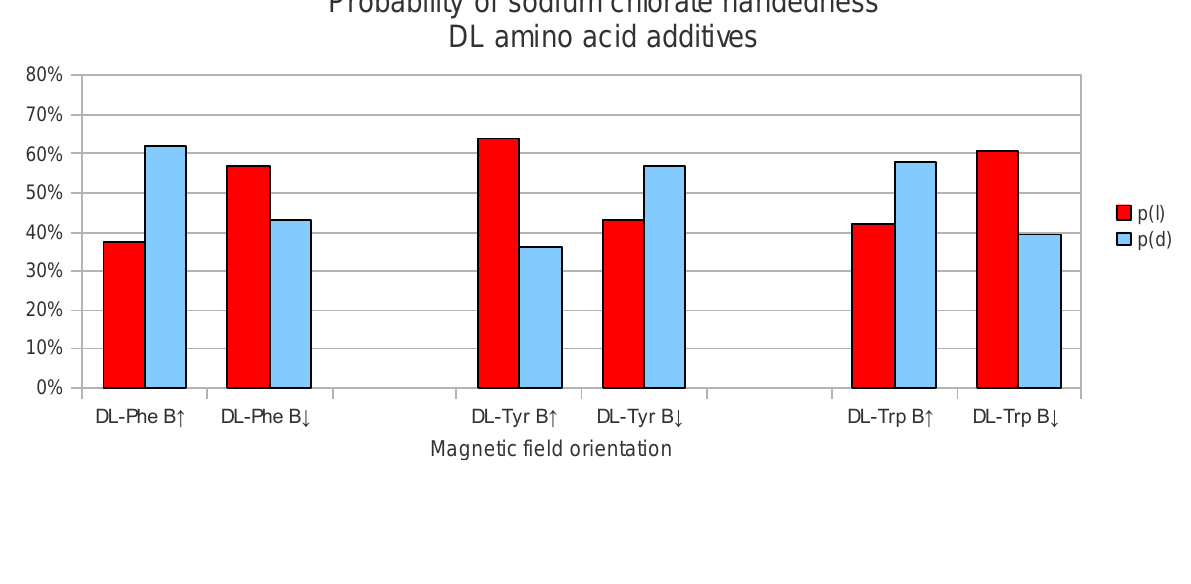
Figure 4. True proportion or probability of sodium chlorate handedness, (l) vs. (d), as function of the magnetic field orientation, for different racemic chiral additives, DL -Phe, DL -Tyr and DL -Trp, in the initial solutions and for opposing magnetic field orientation. The preferred handedness varies with magnetic field orientation suggesting that there is an interaction of the field with chiral amino